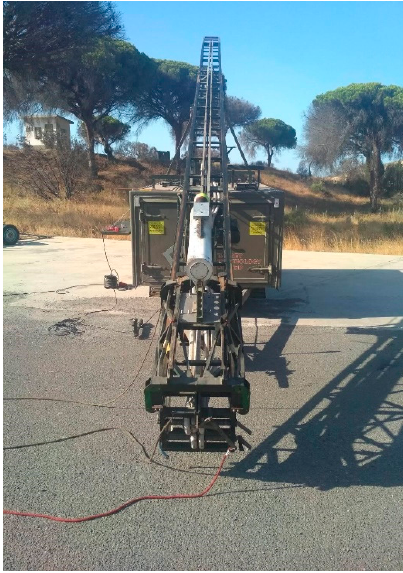
Figure 14. Detail of the QinetiQ© Energy Catapult launcher with a dummy on the ramp.